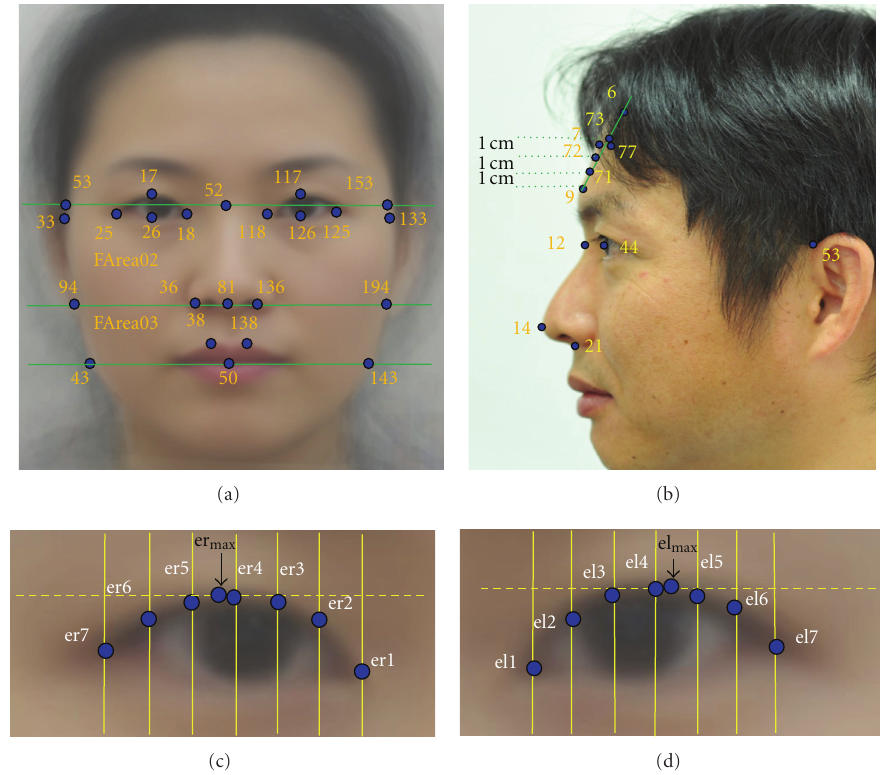
Figure 1: Points used in feature extraction ((a): points and areas in frontal image; (b): points in profile image; (c): points in right eye; (d): point in left